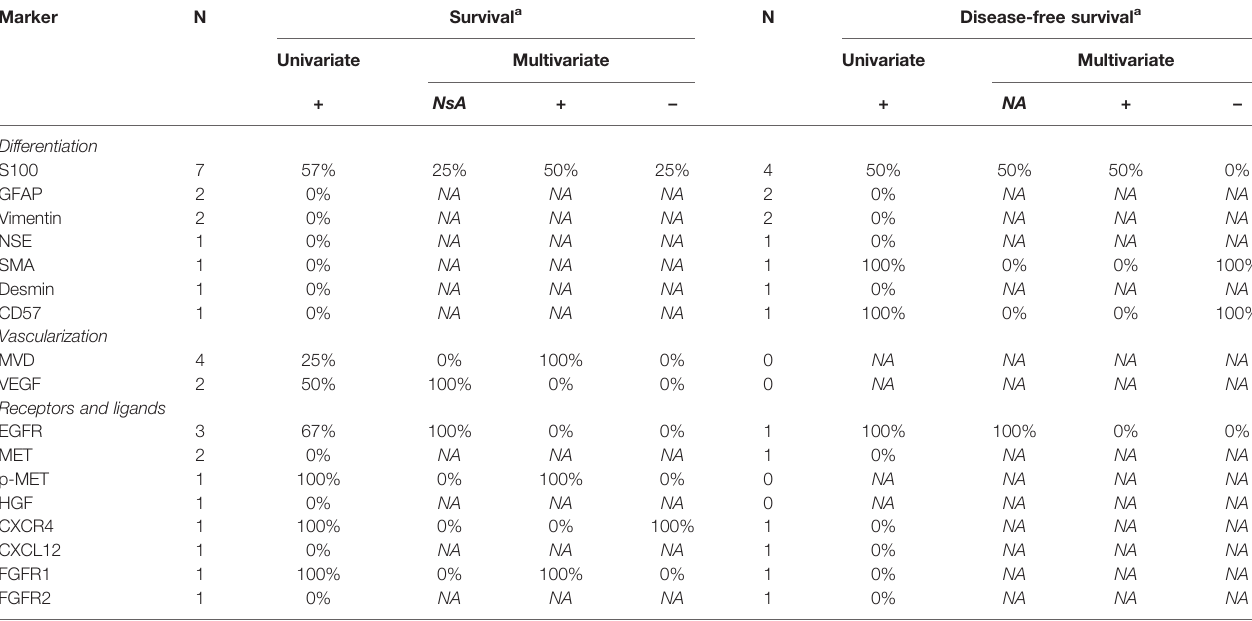
TABLE 2 | Prognostic value of immunohistochemical